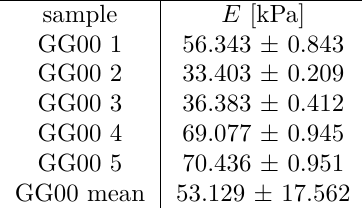
Table 2. Elastic properties of plain GG samples